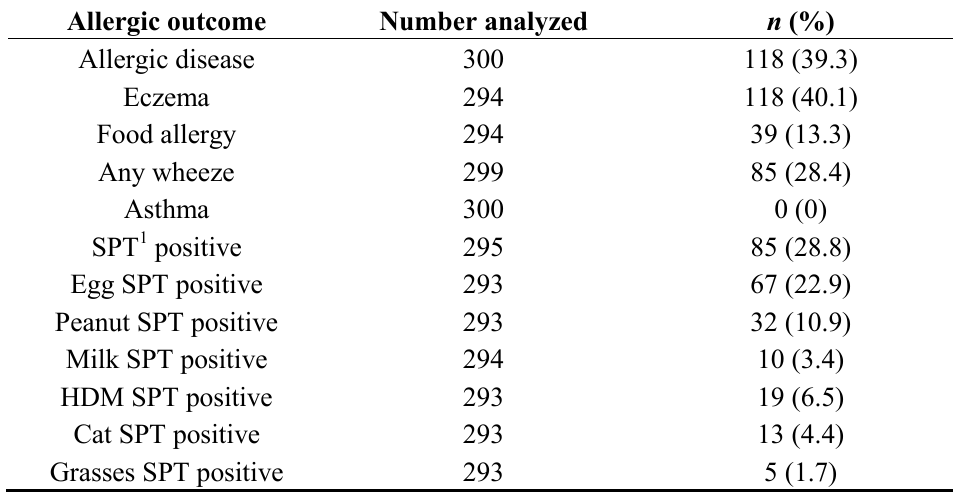
Table 3. Allergic outcomes at 12 months of